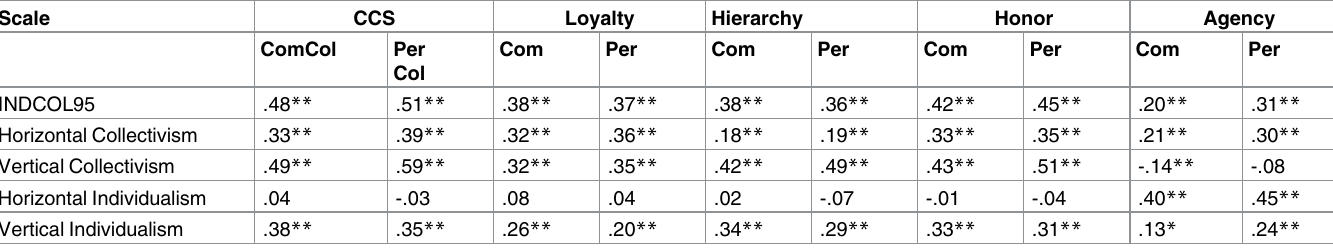
Table 4. Correlations between INDCOL95 and Community Collectivism